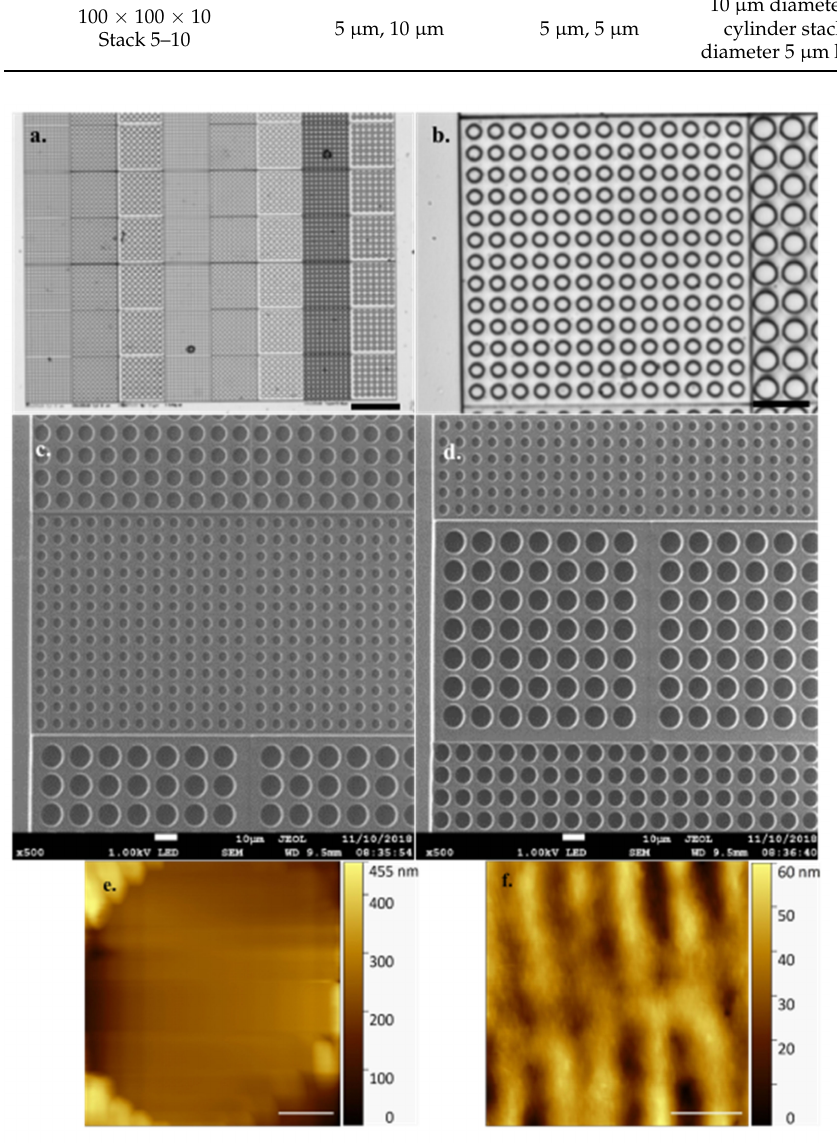
Figure 2. ( a ). Optical microscope images of empty array × 10 obj (Scale bar 100 µ m) and ( b ). × 63 obj (Cyl 5) (Scale bar 20 µ m) ( c ). Scanning electron micrograph of empty array featuring (scale bars 10 µ m) Cyl 8 (top), Cyl 5 (middle), Cyl 10 (bottom) and ( d ). Cyl 5 (top), Cyl 10 (middle), Cyl 8 (bottom) ( e )